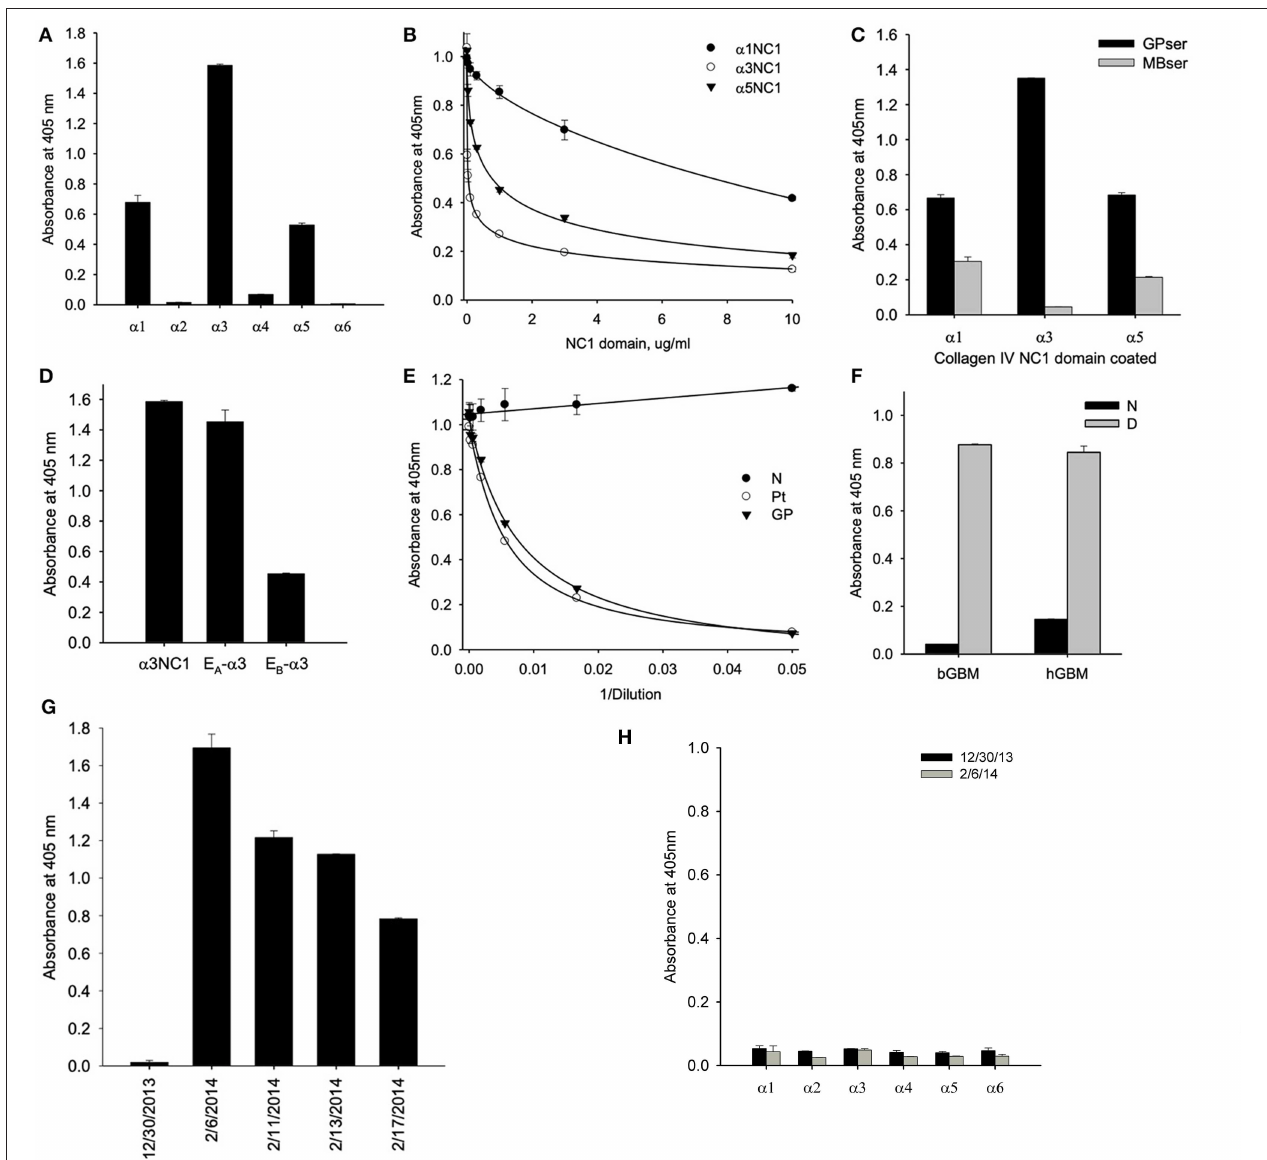
FIGURE 2 | (A) Testing of NC1 domain specificity at the onset of the disease by ELISA showed that antibodies targeted predominantly α 3NC1 domain with a lesser reactivity to α 1 and α 5NC1 domains. (B) Patient serum was pre-incubated with increasing concentrations of the α 1, α 3, and α 5NC1 monomers and binding to corresponding immobilized monomers was measured by ELISA. Differential sensitivity to inhibition by the three NC1 monomers indicates that α 3 antibodies has the highest affinity. (C) Pre-adsorption of patient serum with α 3NC1-coated magnetic beads (MBser) significantly reduced immunoreactivity to α 1 and α 5NC1 monomers compared to original serum (GPser). (D) α 3NC1-specific antibodies predominantly target the E A epitope with lower reactivity to E B epitope. (E) Binding of purified GP antibody labeled with biotin to α 3NC1 monomer was competed by patient serum (Pt), as well as control serum mix from 8 GP patients (GP), but not by the normal human serum (N). (F) Patient’s antibodies strongly react with the denatured NC1 hexamers from bovine (bGBM) or human (hGBM) glomerular basement membrane, while minimally react with native NC1 hexamers. (G) ELISA analysis of serial serum samples demonstrated the absence of anti-GBM antibodies 5 weeks prior to presentation (12/30/2013) by comaprison with normal human serum (NHS), with a rapid and strong development of immunoreactivity in 5 weeks. (H) There was no IgM binding to any of the six human recombinant NC1 domains of collagen IV in serum samples collected before or at the onset of the disease. The dashed line indicates threshold determined as mean ± 3x SEM for normal human serum.